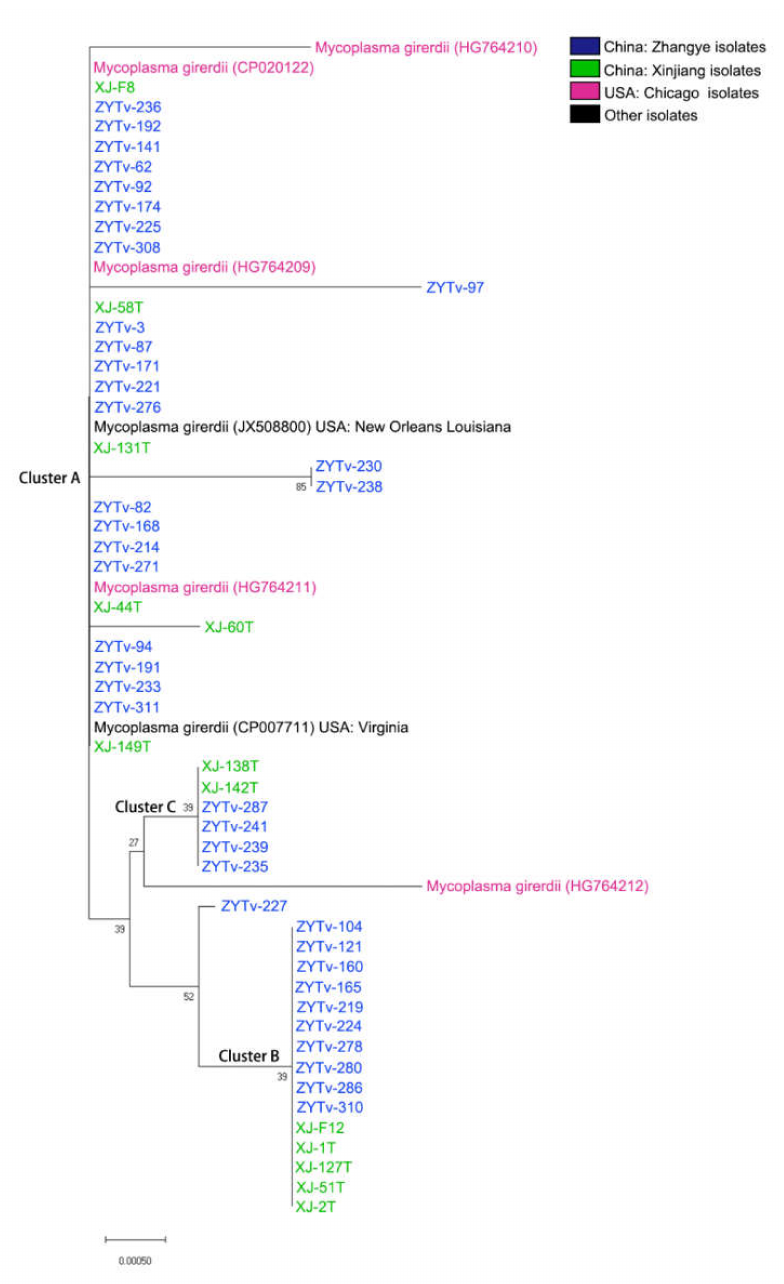
Figure 1. NJ tree analysis of 16S rDNA gene sequences showing the phylogenetic position of the Zhangye Ca . M. girerdii gene se-quence within all Ca . M. girerdii gene sequences reported in GenBank (Xinjiang samples were collected by Liu Jun in our laboratory). The tree was derived using 16S rDNA gene sequences (approximately 1200 nucleotides) obtained from GenBank. Original values are shown at the branch points. Gene accession numbers and sample source locations are shown after the organism names included in the